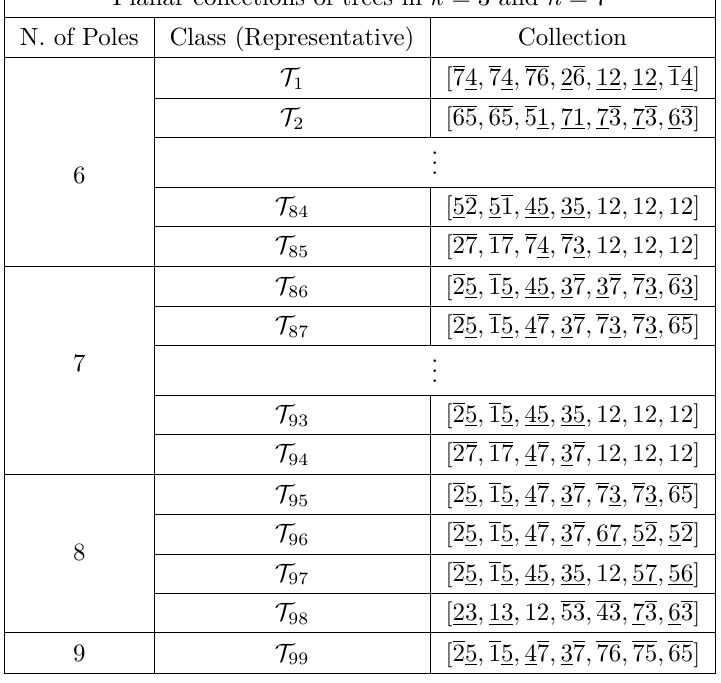
Table 2 . Some representative collections from the contributing planar families in the n = 7 planar amplitude. Each representative belongs to a defined family of planar arrangements, each of which contribute with a number of planar collections shown in the rightmost